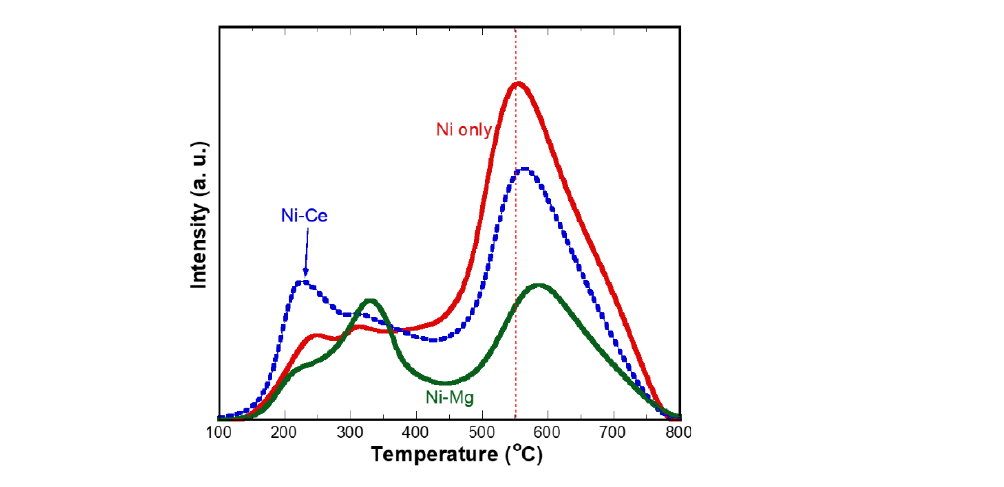
Figure 8. Temperature programmed reduction (TPR) profile of Ni/Eco, Ni-Ce/Eco, and Ni-Mg/Eco. The TPR results distinguished the effect of metal-promoter interactions on the reducibility of Ni. The profiles of all three samples were generally similar, showing unsymmetrical major peaks at 450–700 ◦ C and relatively weak overlapped peaks at 150–400 ◦ C. The low temperature (<400 ◦ C) peaks correspond to the free or weakly bound NiO